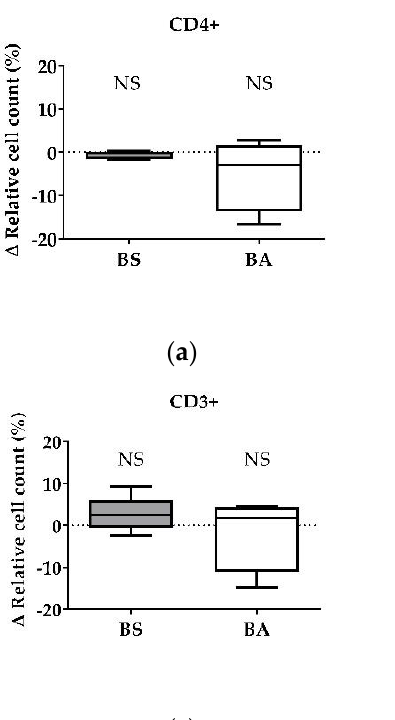
Figure 5. Influence of UV-inactivated B. subtilis DSM 32315 (grey) and B. amyloliquefaciens CECT 5940 (white) on the proliferation of T and B cells. Isolated PBMCs were treated with either UV- inactivated BA or BS or left untreated (negative control). After treatment for 24 h, immune cells were labeled with monoclonal antibodies. The relative cell count was related to untreated controls. DAPI was used as a viability marker. ( a ) CD4+ T-helper cells, ( b ) CD8+ cytotoxic T cells, ( c ) all CD3+ T cells, and ( d ) Bu-1+ B cells relative to the vital PBMC cell count. 20,000 vital PBMCs were recorded on a BD FACSCanto II flow cytometer. Data represent 4 (BA) or 5 (BS) biological replicates. Results are presented as box and whisker plots showing the median, with a 25 – 75 percentile range as the box and min to max as the whiskers. Significance is shown as **, p < 0.01; NS: not significant.